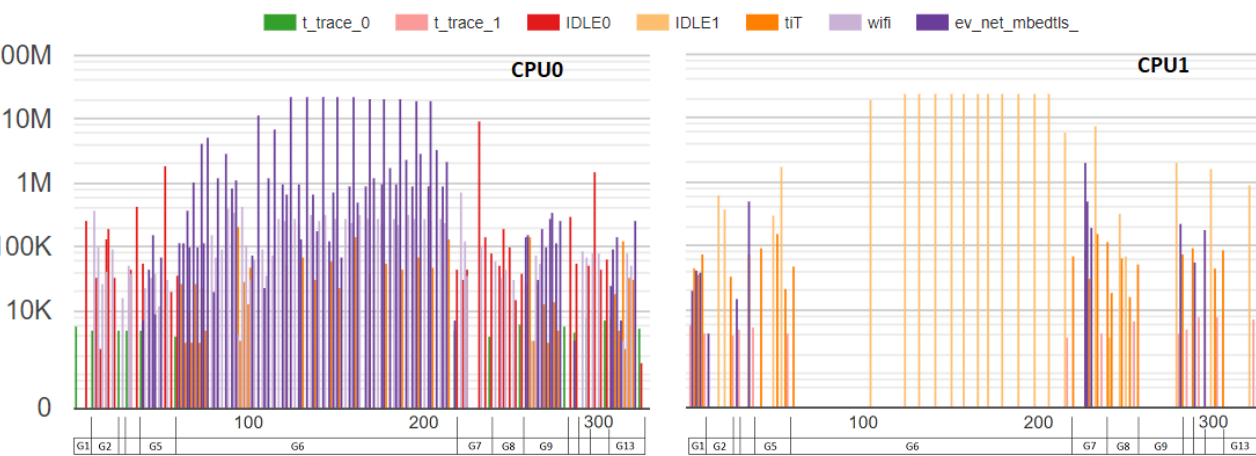
Figure 3. Scheduler trace example. A device with 2 CPUs running at 240Mhz. On the vertical axis, on the logarithmic scale, is the number of cycles used by each task when occupying a CPU. The horizontal axis presents the step in which the scheduler removes the task from execution, in reference to a single scheduling counter of the experiment. Task names are presented along the